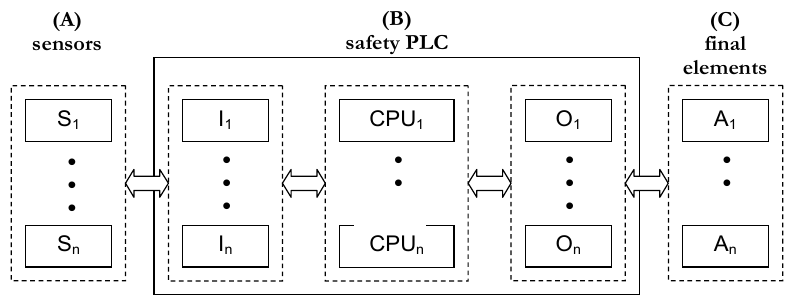
Figure 2. General configuration of a safety system ( A )—sensors, ( B )—safety PLC, ( C )—final ele- ments.